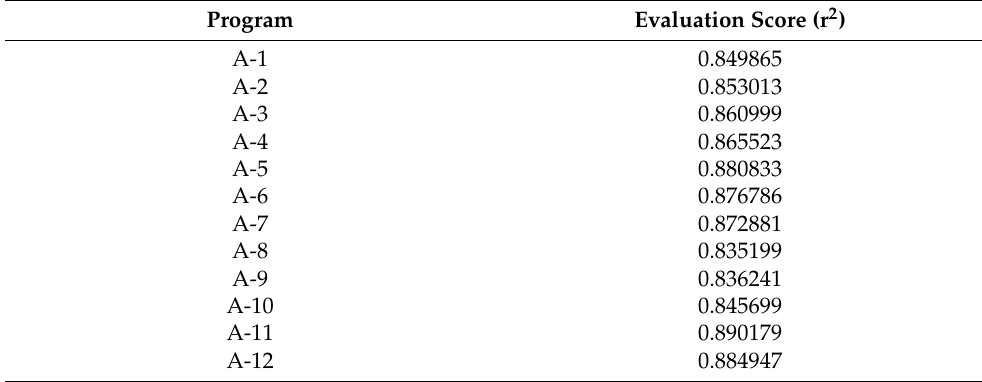
Table 4. Pearson correlation coefficient comparison table.